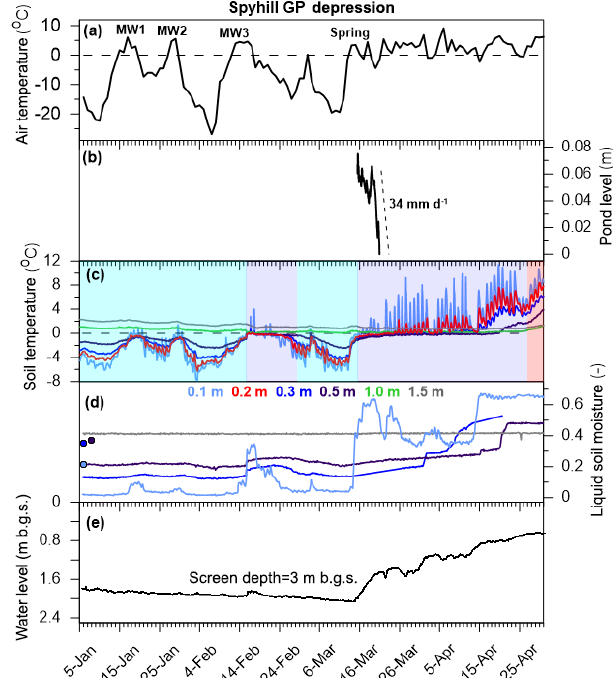
Figure 8. Temporal variability of hydrologic variables during the monitoring period for Spyhill GP depression showing (a) the av- erage daily temperature and the identification of snowmelt events; (b) the depression pond level measured by a pressure transducer, with the dashed lines indicating the recession rate during the Spring snowmelt event; (c) soil temperatures; (d) liquid soil moisture, with pre-freezing values shown as circles; and (e) the groundwater level measured in piezometers, with the screen depth indicating the mid- point of the screen interval. In panel (b) , blue shading indicates frozen ground, purple indicates partially frozen ground, and red in- dicates unfrozen